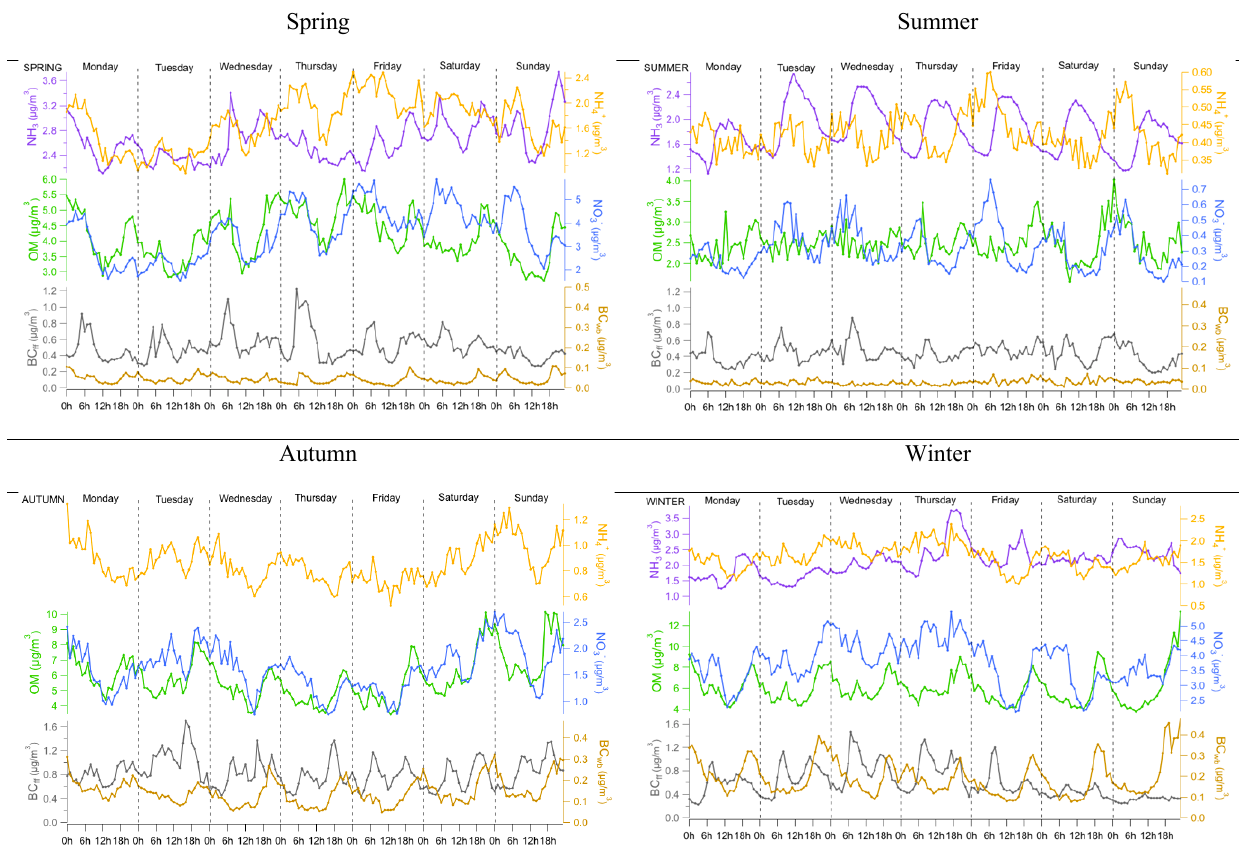
(blue), NH + (dark yellow), NH 3 (purple), BC ff (black) and BC wb 3 4